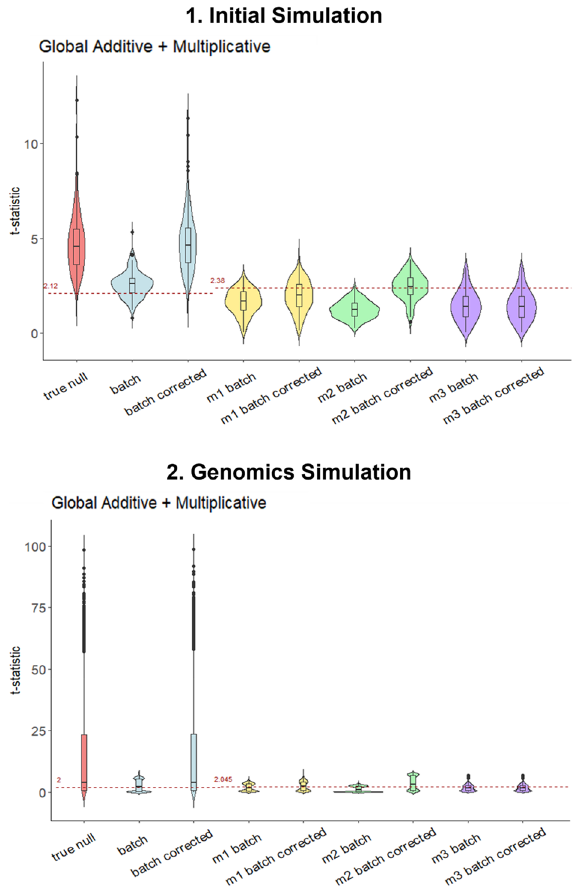
Figure 8. t-statistic distributions for 1. Initial Simulation and 2. Genomics Simulation reveal that although power is the best for M2, all imputation strategies (M1–M3) suffer from a reduction in effect